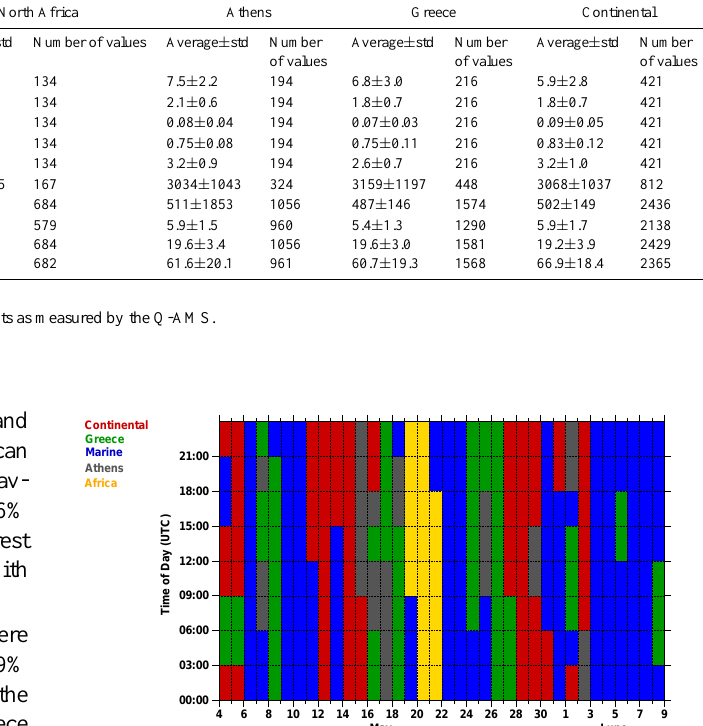
Variable Instrument Average ± std Number